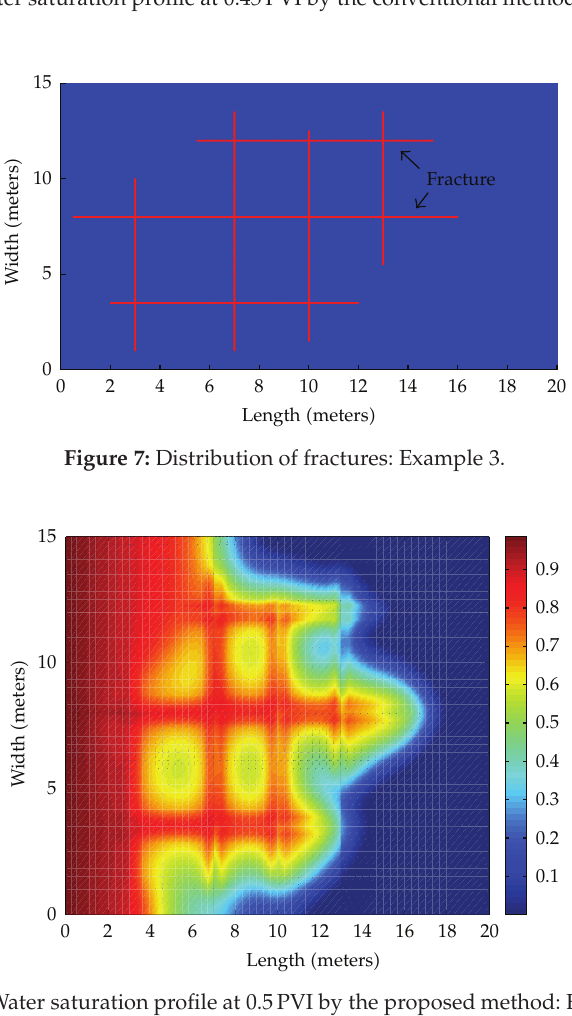
Figure 6: Water saturation profile at 0.45 PVI by the conventional method: Example 2.